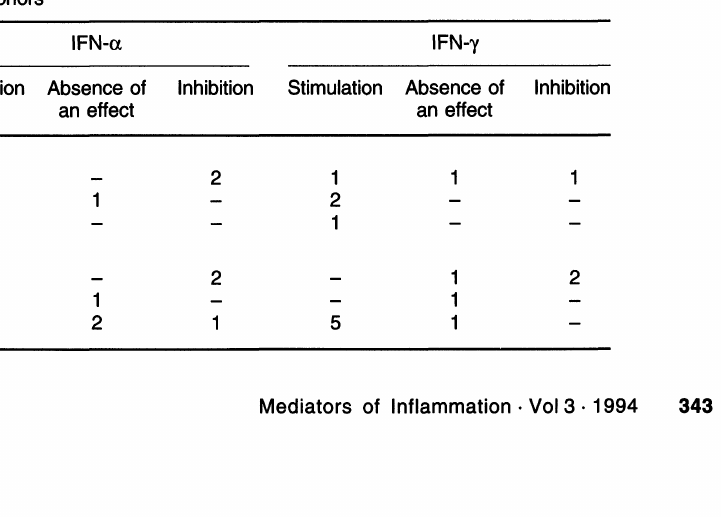
Table 3. The relationship between initial NK cytotoxicity and the effects of auto-IFNs on PBL NK activity. Results are given for MS patients and healthy donors Initial NK